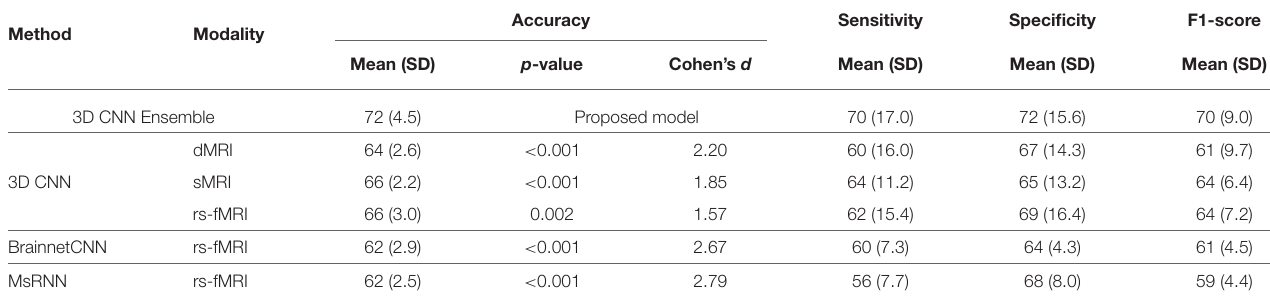
TABLE 2 | Classification performance in percentage.